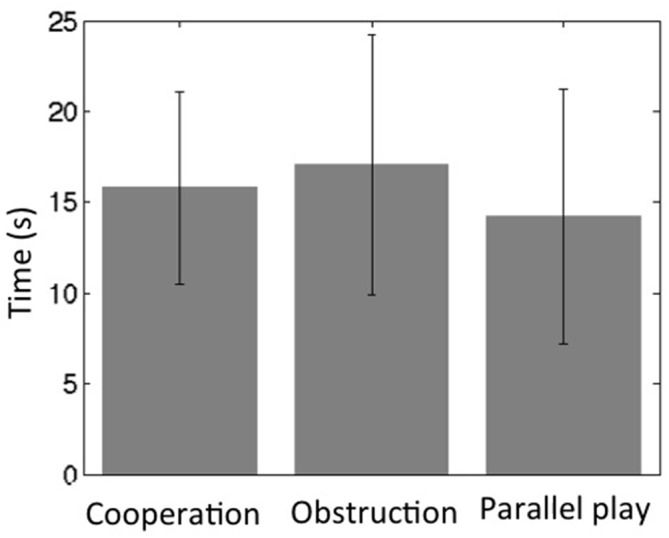
Social interaction frequency during three task conditions (bars represent standard deviation).